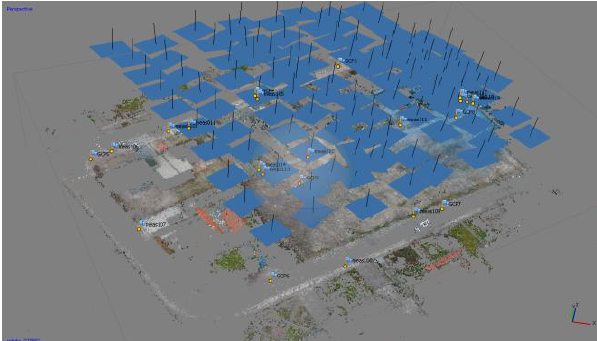
Figure 10: Professional ground marker for geometrical corrections